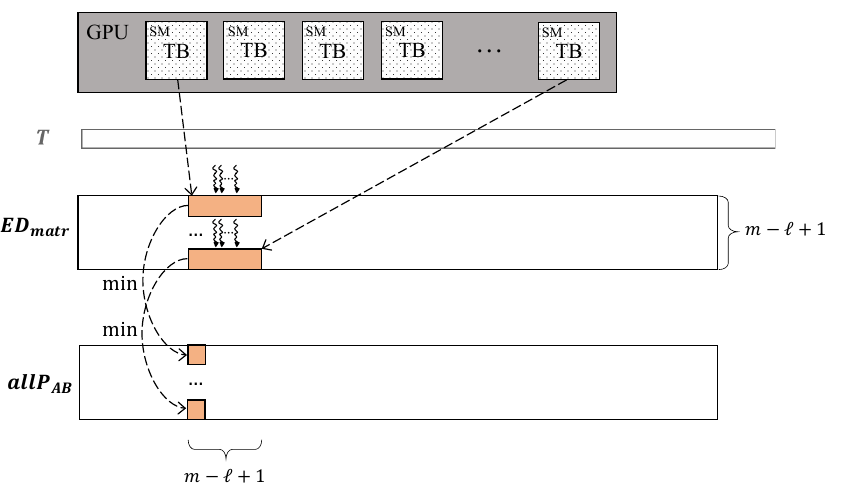
Figure 3. CUDA kernel to compute allP AB .